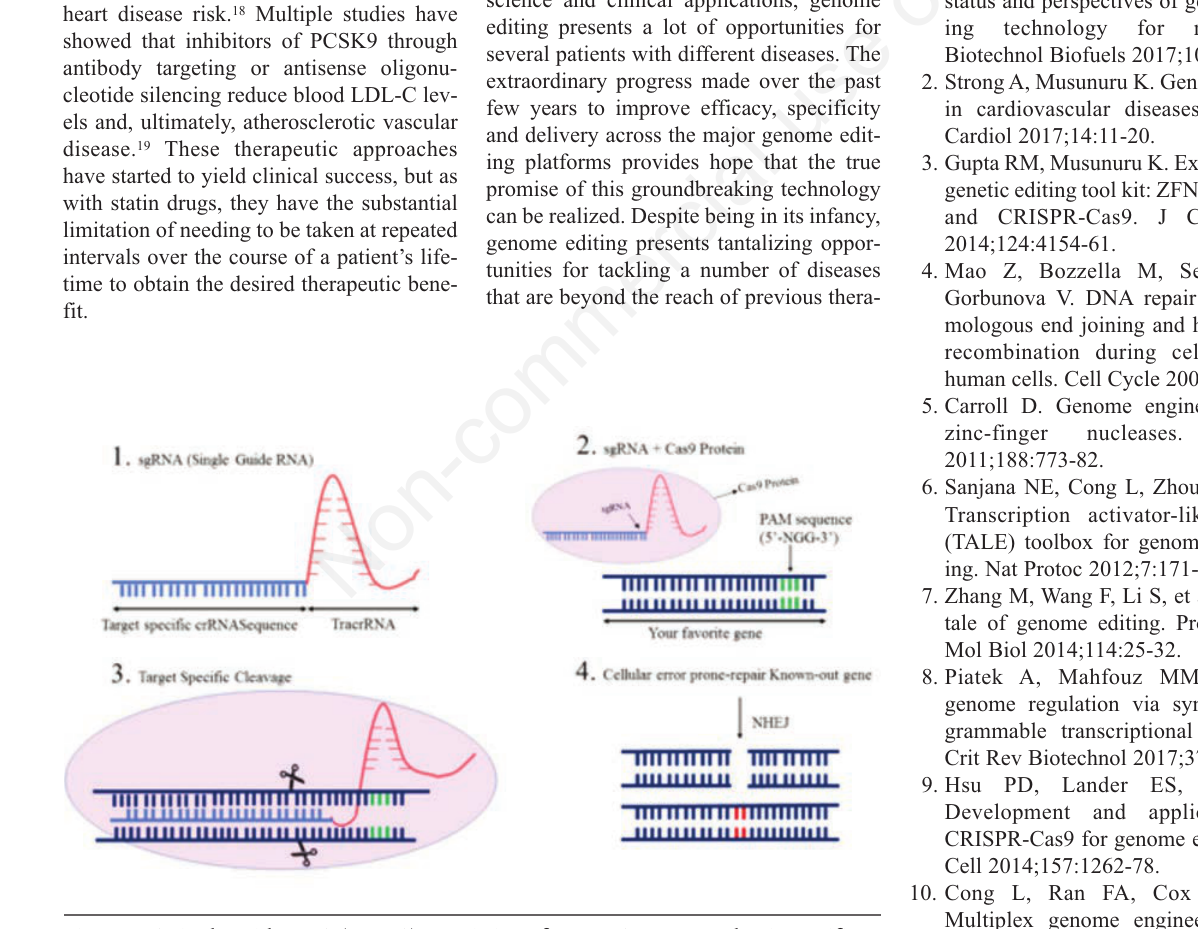
Figure 3. A single guide RNA (sgRNA), consisting of a crRNA sequence that is specific to the DNA target, and a tracrRNA sequence that interacts with the Cas9 protein (1), binds to a recombinant form of Cas9 protein that has DNA endonuclease activity (2). The resulting complex will cause target-specific double-stranded DNA cleavage (3). The cleav- age site will be repaired by the non-homologous end joining (NHEJ) DNA repair path- way, an error-prone process that may result in insertions/deletions (INDELs) that may disrupt gene function